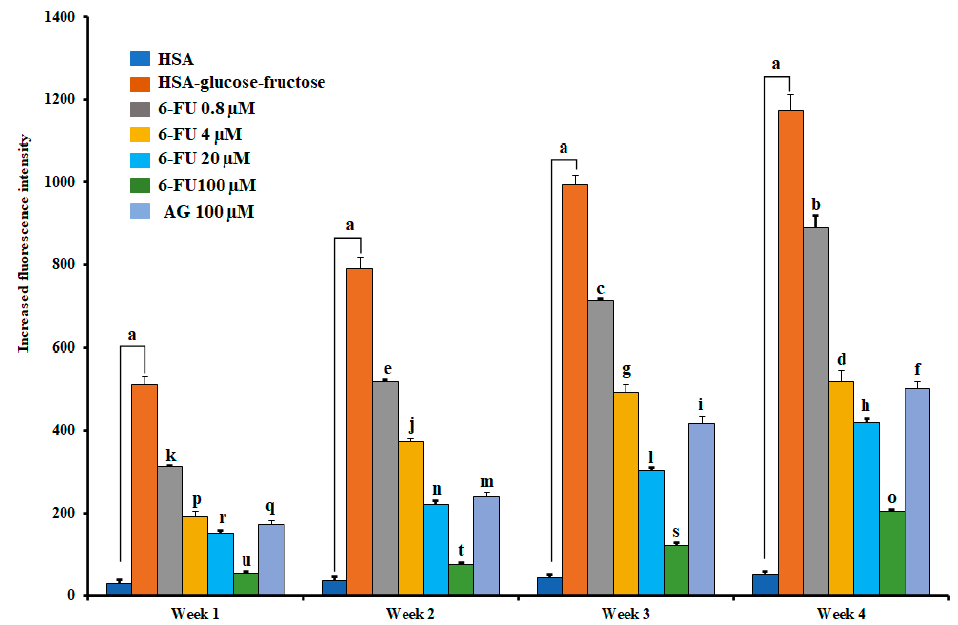
Figure 7. The inhibitory effect of 6-formyl umbelliferone (6-FU) and aminoguanidine (AG) on the formation of fluorescent advanced glycation end-products (AGEs) in the human serum